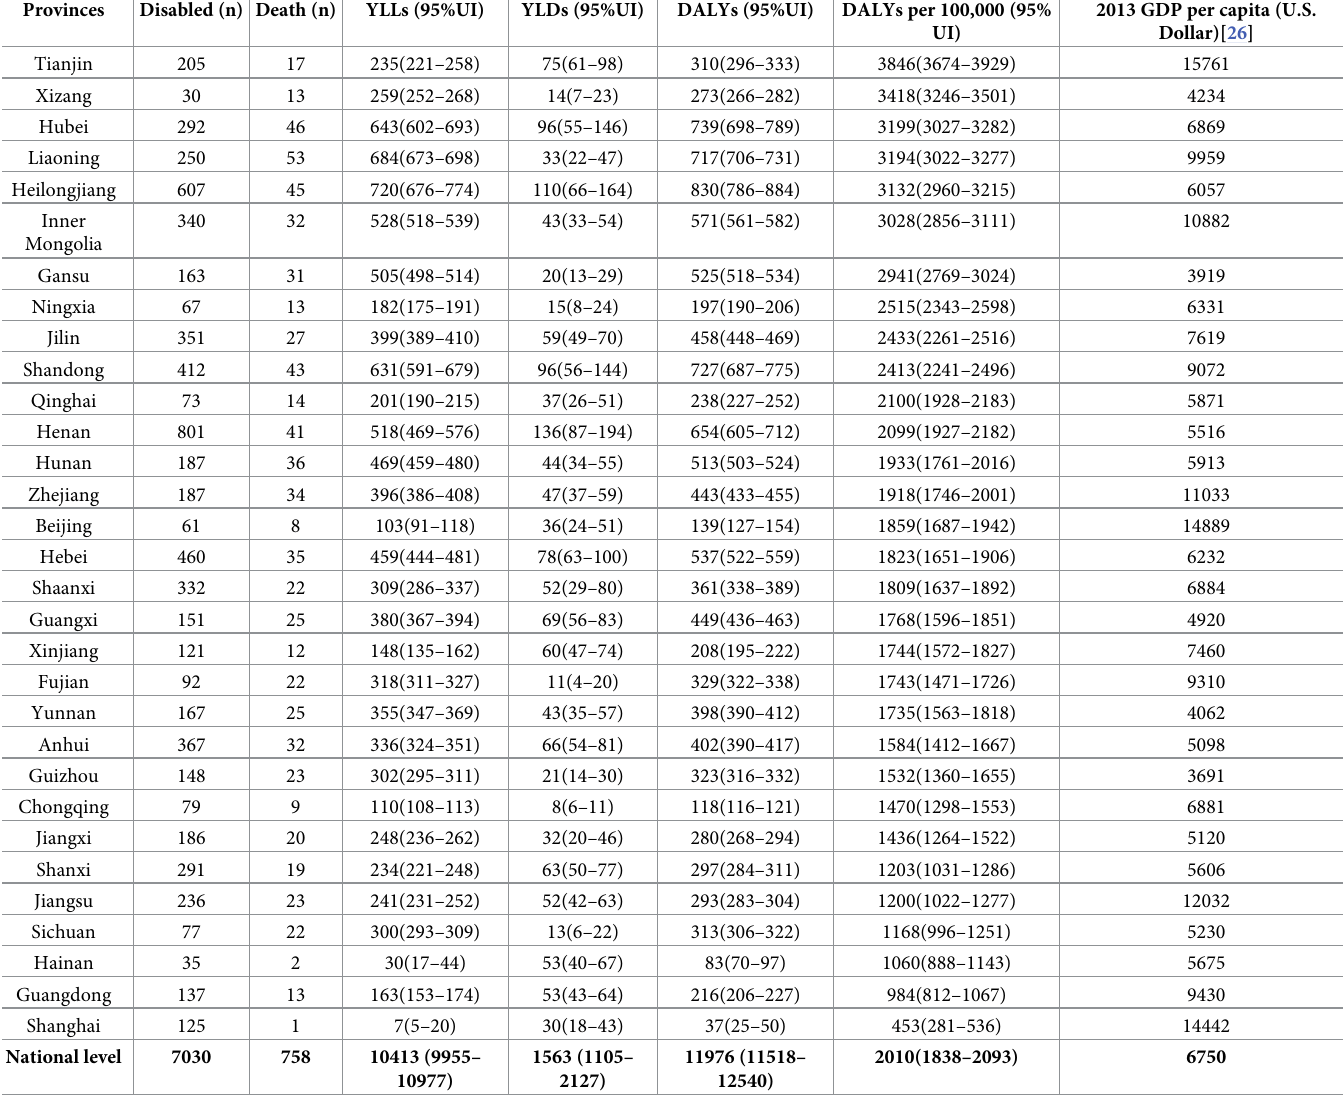
Table 1. The provincial detail of the population of disabled and death due to stroke and the absolute value of YLLs, YLDs and DALYs of stroke in all age groups obtained by NESS-China at 155 survey sites in 31 provinces nationwide � . Provinces Disabled (n) Death